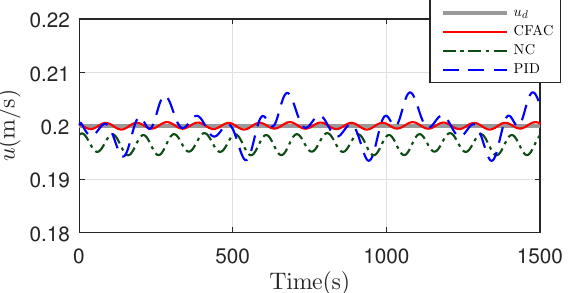
Figure 10. Velocity tracking performance in submerging motion with a constant velocity and variable pitch angle command.